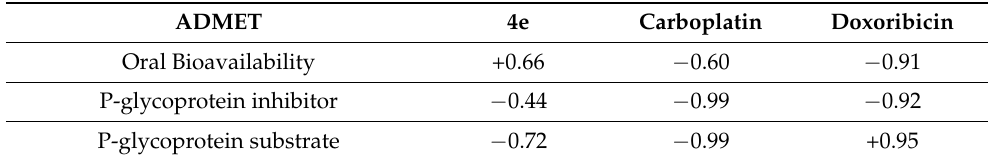
Table 5. Predicted pharmacokinetic properties of compound 4e and the chemotherapeutic agents, carboplatin, and doxorubicin, using the admetSAR 2.0 server. ADMET